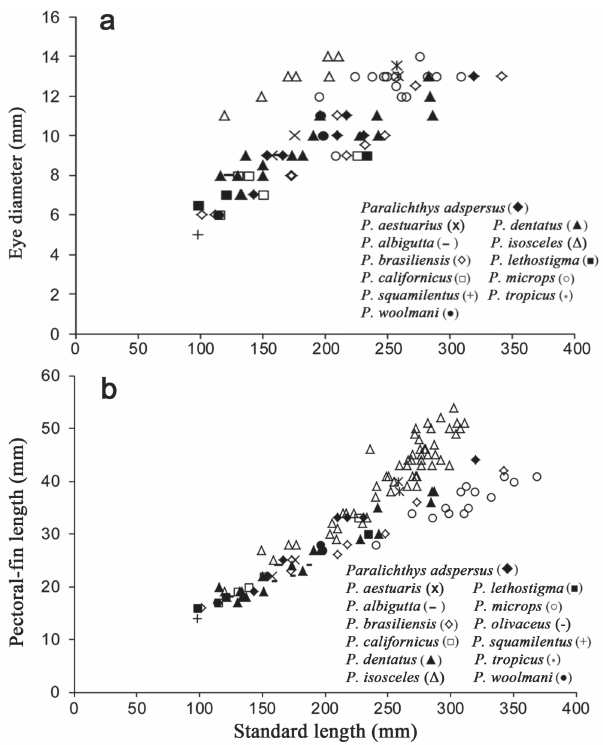
Fig. 9. Relationships of eye diameter to standard length ( a ); and prepectoral-fi n length to standard length ( b ); in Paralichthys adspersus , P. aestuarius , P. albigutta , P.